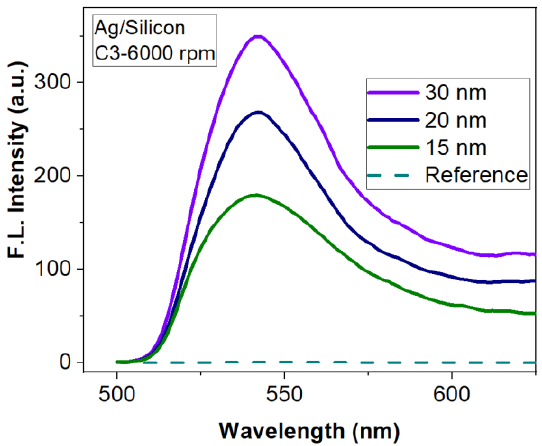
Figure 12. Influence of Ag metasurfaces/silicon substrate on FLEN.